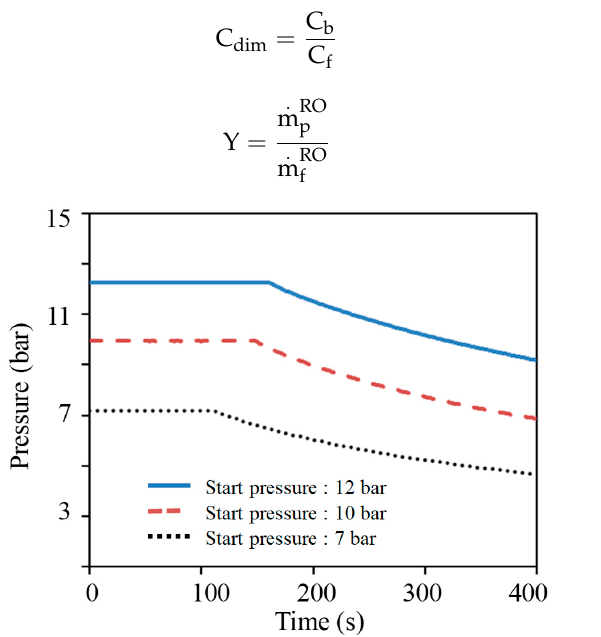
Figure 11. Applied pressure profiles starting at 7, 10, or 12 bars, consisting in a plateau followed by a decreasing evolution.